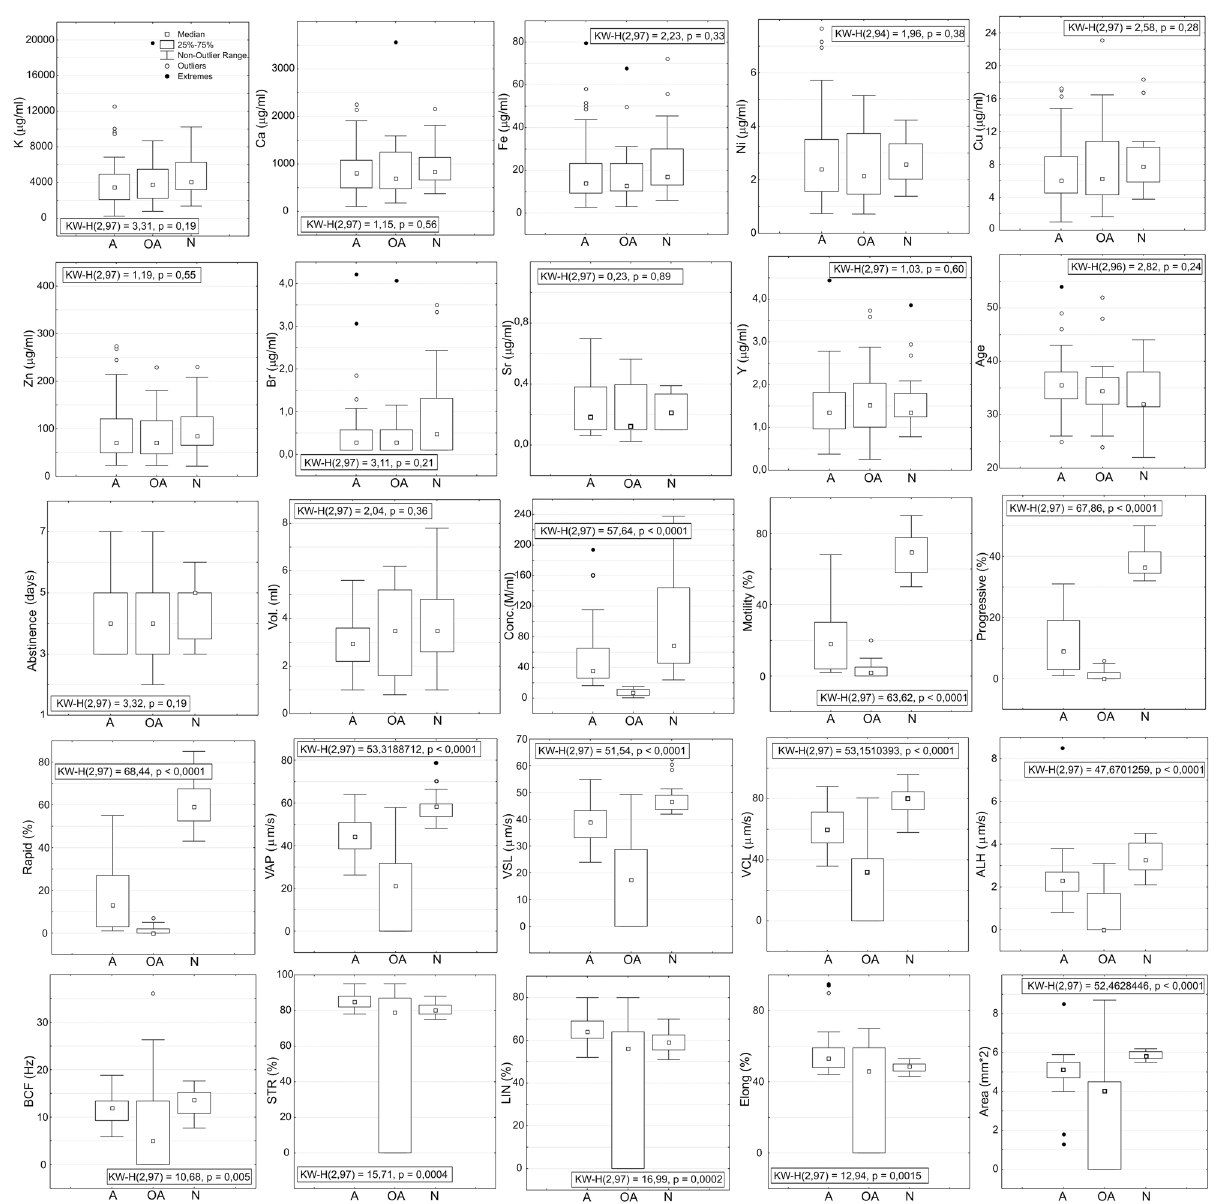
Fig 1. Box-plots of trace-element concentrations, patient ages, days of abstinence and sperm-quality parameters. Groups of men diagnosed with normozoospermia (N), asthenozoospermia (A) and oligoasthenozoospermia (OA) were statistically different with respect to all sperm quality parameters and sperm concentration. No significant difference was found in concentrations of chemical elements among these three groups of patients. Results of Mann- Whitney U test and Tukey HSD showed that A and N groups were statistically significantly different with respect to STR, LIN, “ elongation ” , VCL and ALH indicating increased expression of spontaneous spermatozoa hyperactivation among patients with normal spermiogram according to WHO criteria. The distribution of sperm quality parameters for OA group of patients was not compared to other two groups as being heavily influenced by “ 0 ”